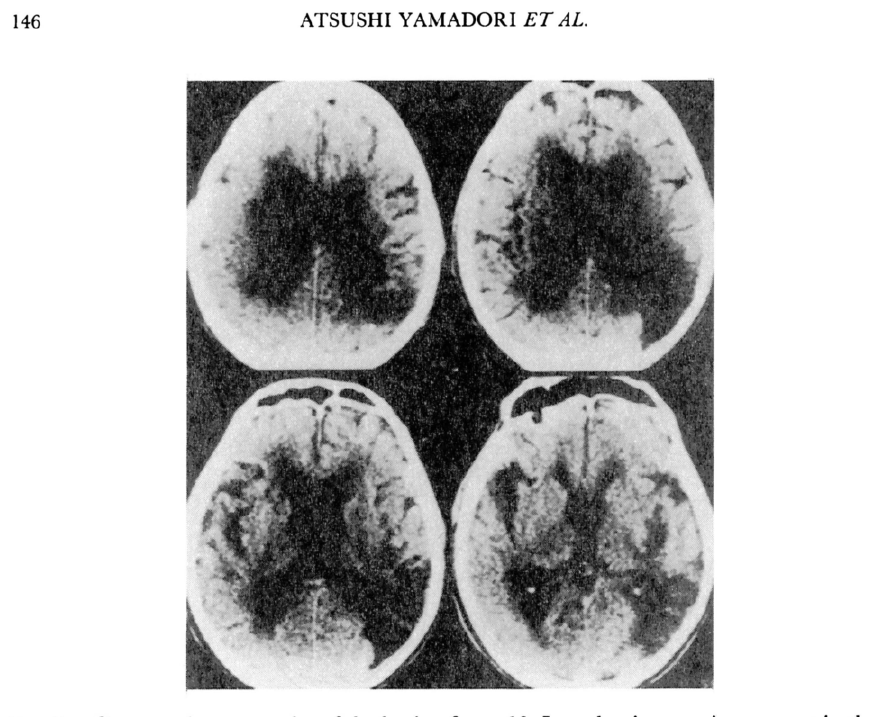
FIG. 2. Computed tomography of the brain of case 10. Low density area is apparent in the posterior portion of the right tcmporo-parictal